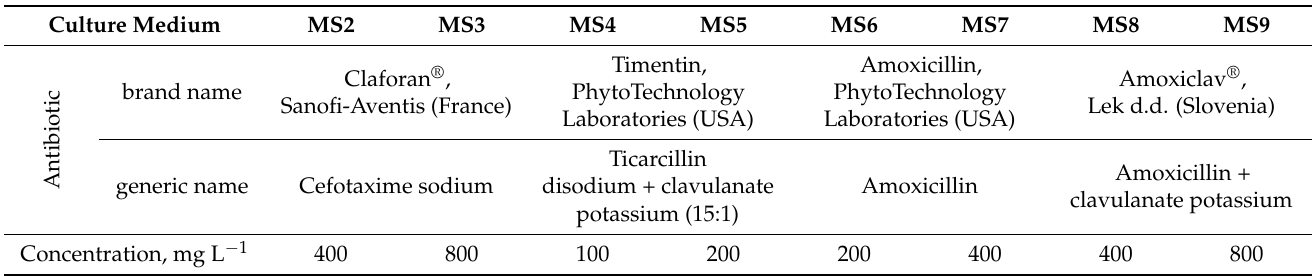
Table 1. Types and concentrations of β -lactam antibiotics used in MS culture media for in vitro callus induction and shoot organogenesis of